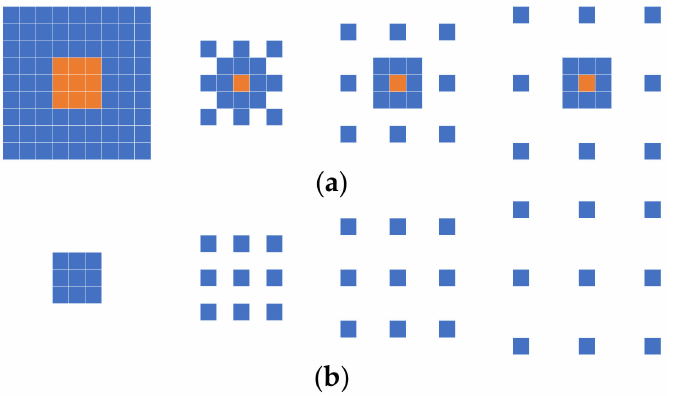
Figure 7. Composite convolutional kernel structure diagram: ( a ) construction in the multiscale large-kernel residual convolution block (MLRB) (orange indicates the composite part of the two convolutional kernels) and ( b ) the regular dilated